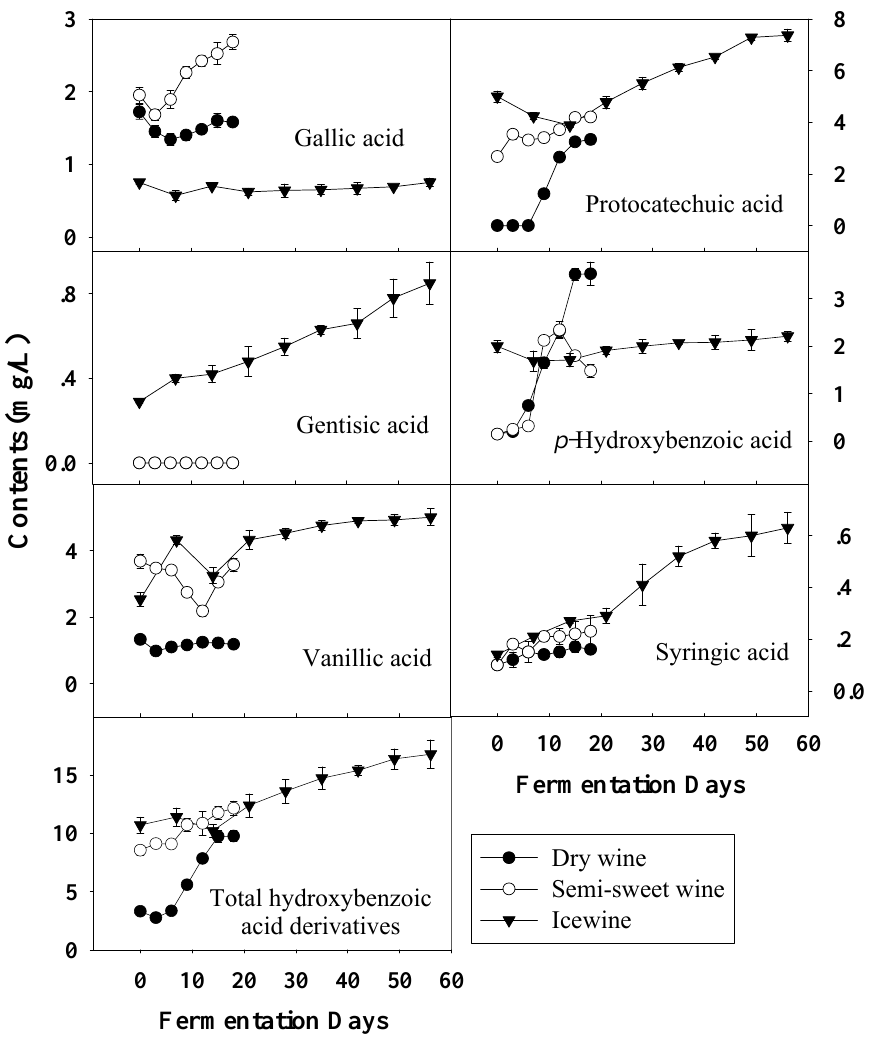
Figure 5. Evolution of hydroxybenzoic acid derivatives during the fermentation of dry wine, semi-sweet wine and